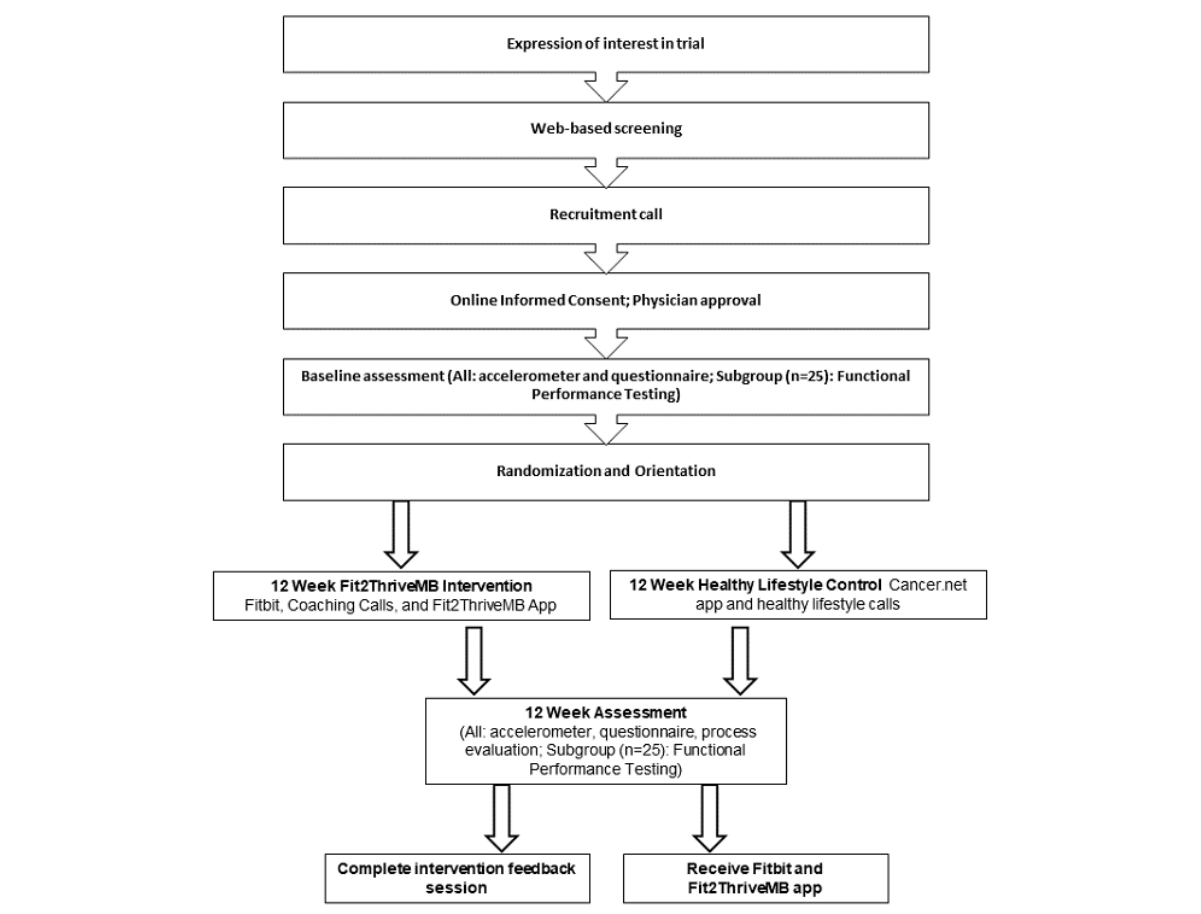
Figure 1. Fit2ThriveMB participants flow through the